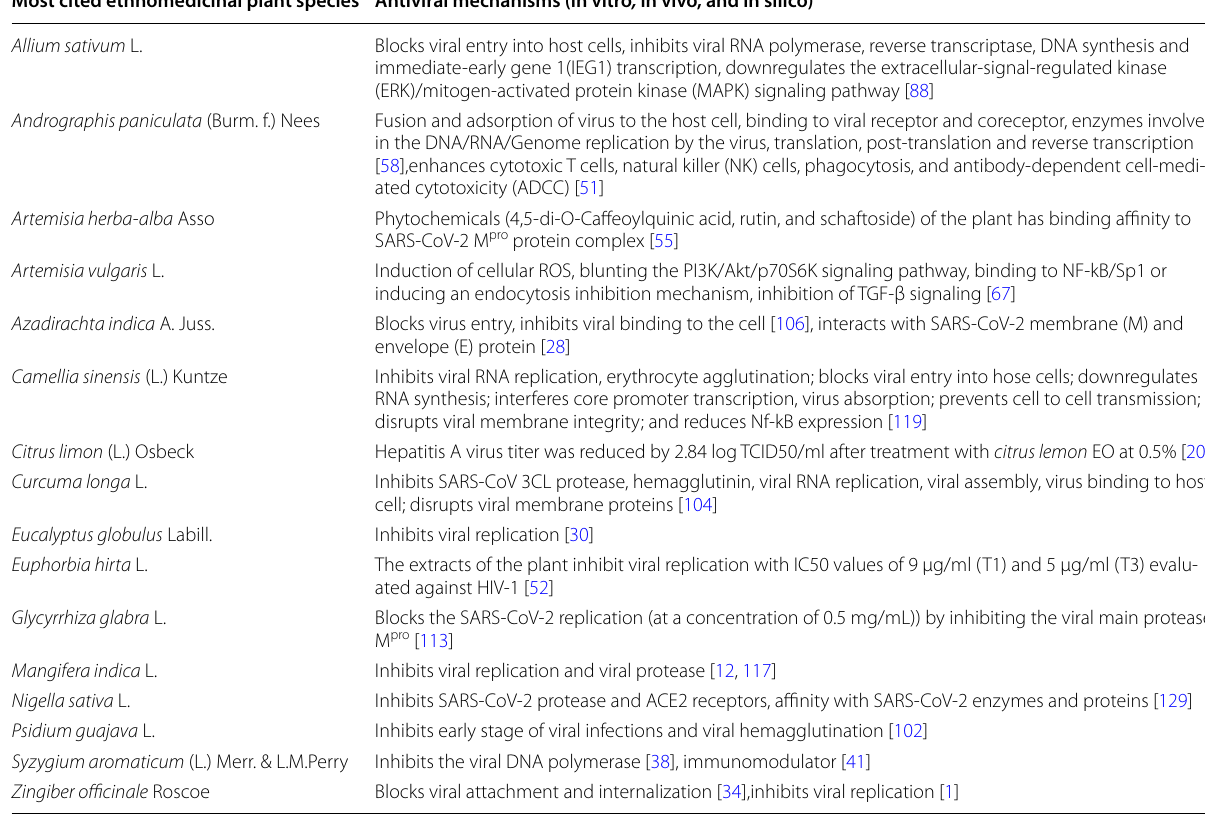
Table 3 Antiviral mechanisms of the most cited ethnomedicinal plants used for SARS-CoV-2 causing COVID-19 and associated symptoms reported from diverse geographical locations Most cited ethnomedicinal plant species Antiviral mechanisms (in vitro , in vivo, and in silico) Allium sativum